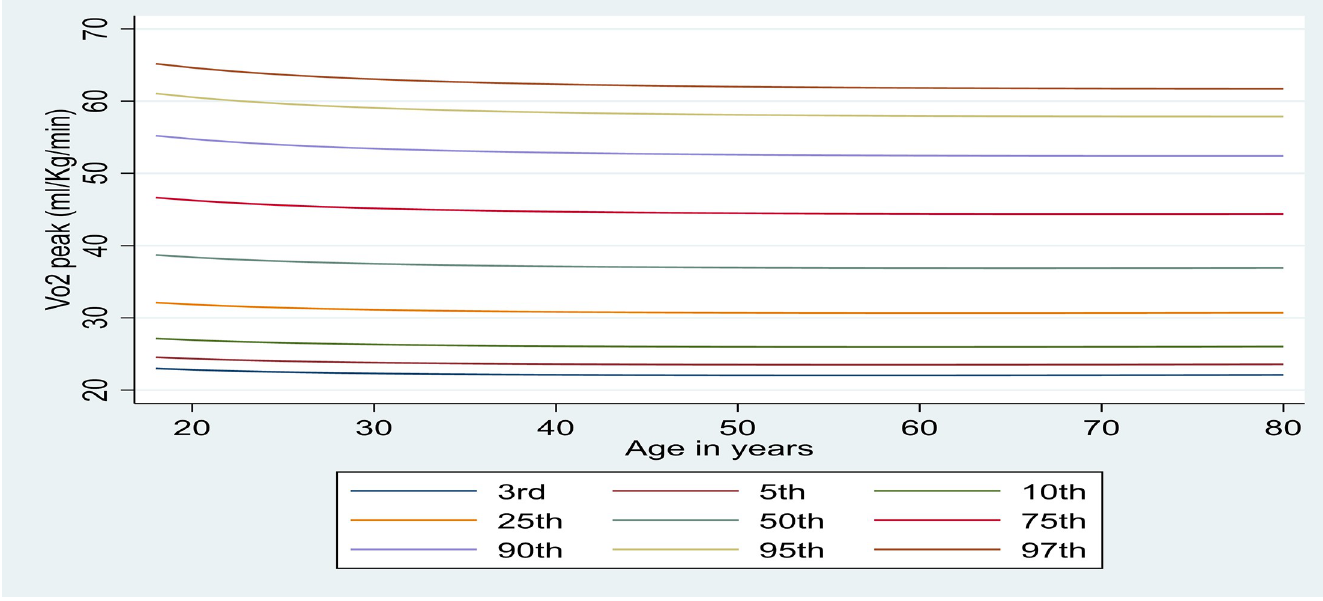
Fig 1. Peak VO 2 (ml � kg -1 � min -1 ) centile reference curves in apparently healthy British males.